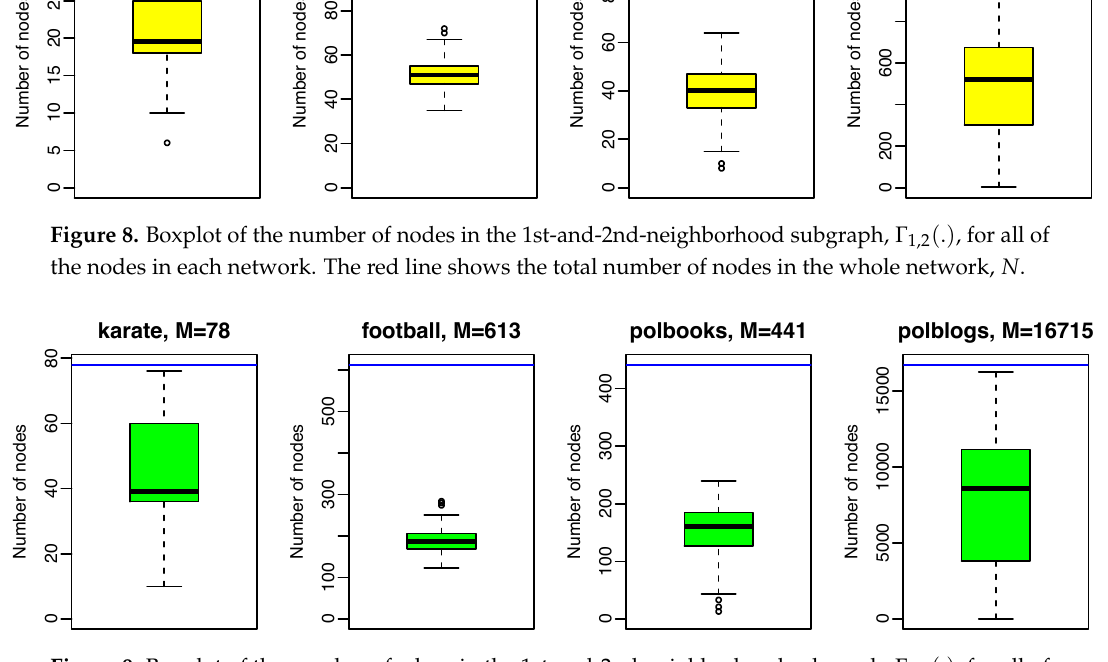
Figure 9. Boxplot of the number of edges in the 1st-and-2nd-neighborhood subgraph, Γ 1,2 ( . ) , for all of the nodes in each network. The blue line shows the total number of edges in the whole network, M